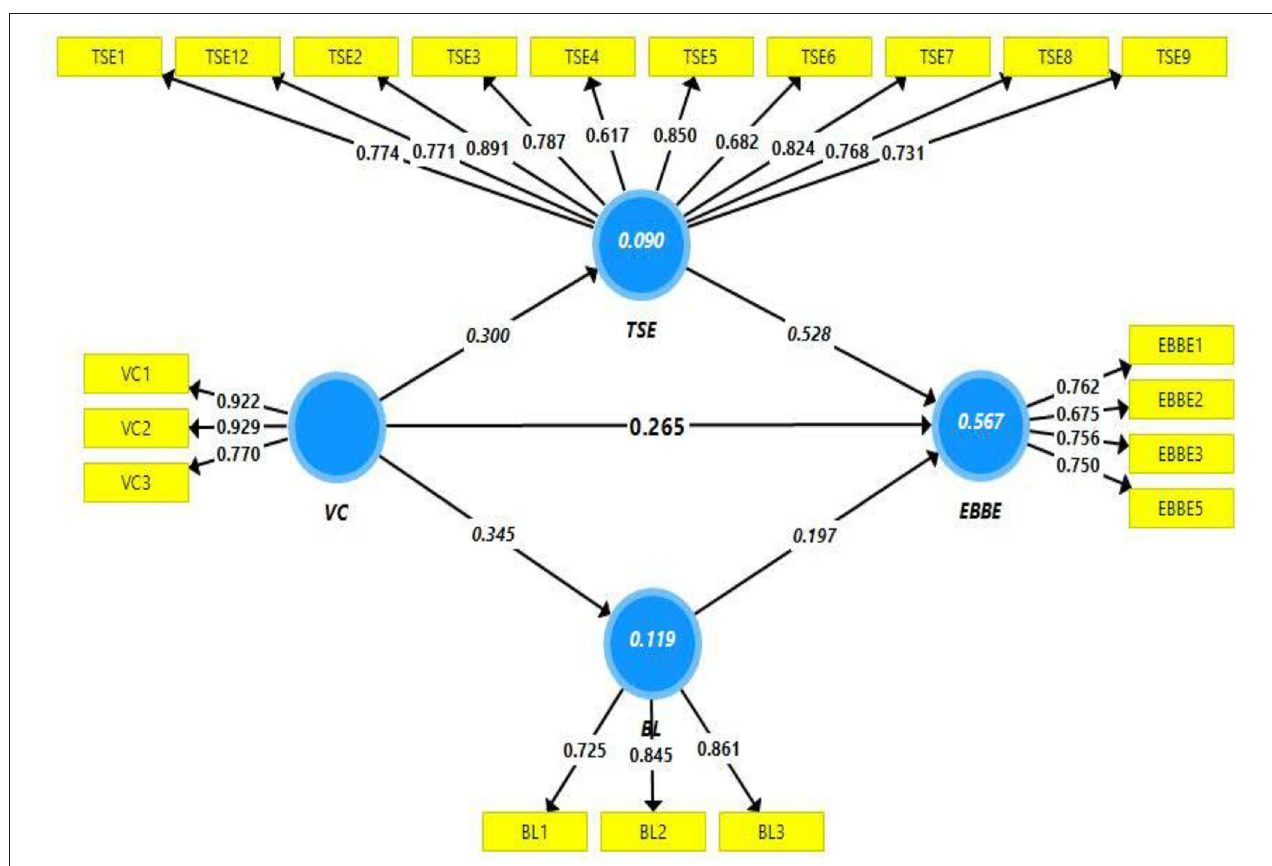
FIGURE 2 | Path estimates.